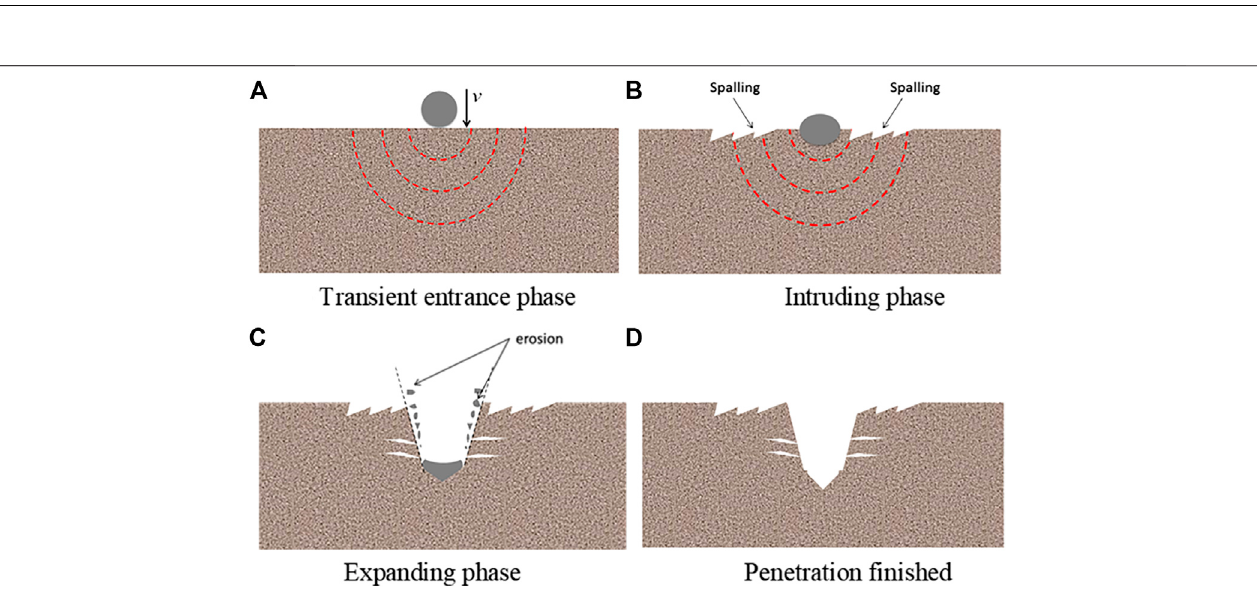
FIGURE 8 | Schematical diagram of penetration process G50 steel target impacted by a tungsten ball (Zhao et al., 2015). (A) Transient entrance phase, (B) intruding phase, (C) expanding phase, and (D) penetration fi nished.